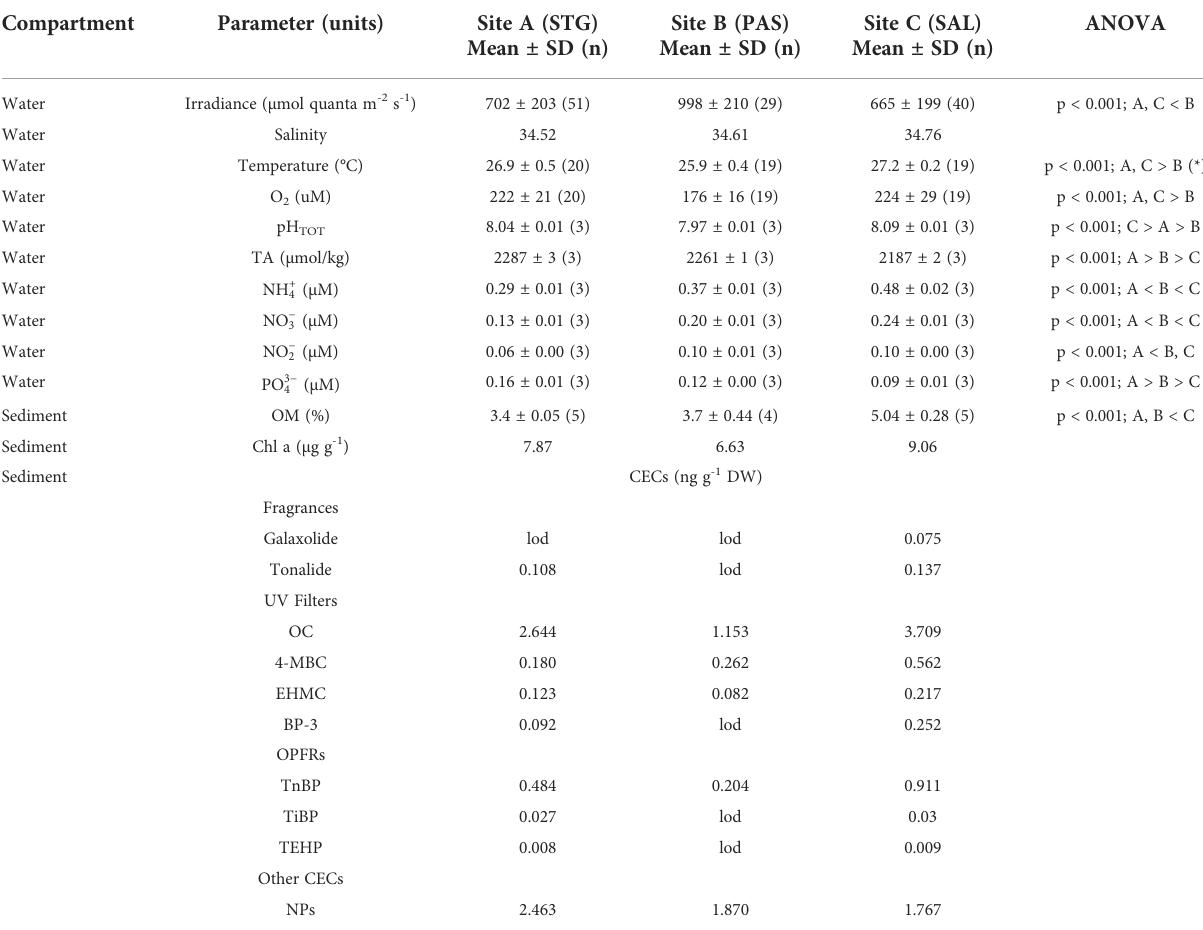
TABLE 1 Lagoon biogeochemical descriptors.